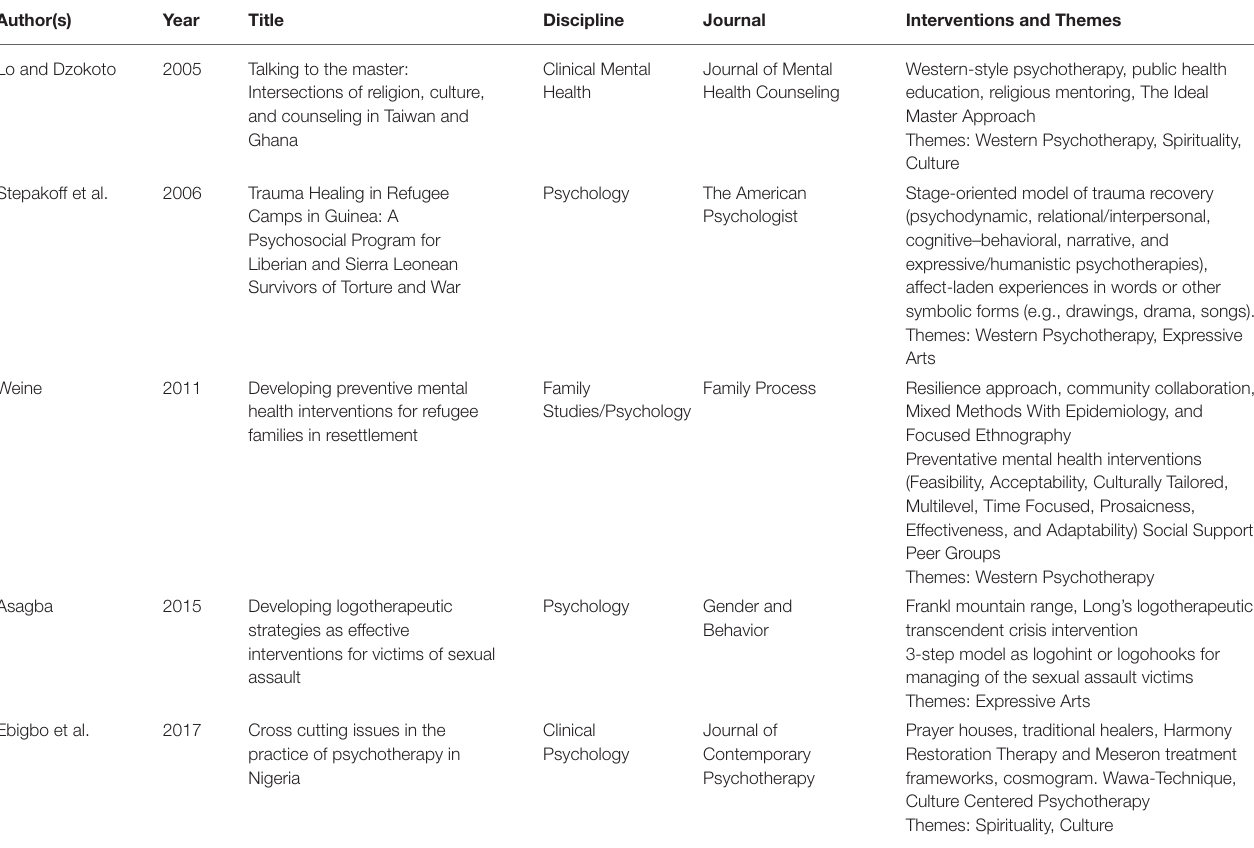
TABLE 2 | Five journal articles selected between 2005 and 2020 included in systematic